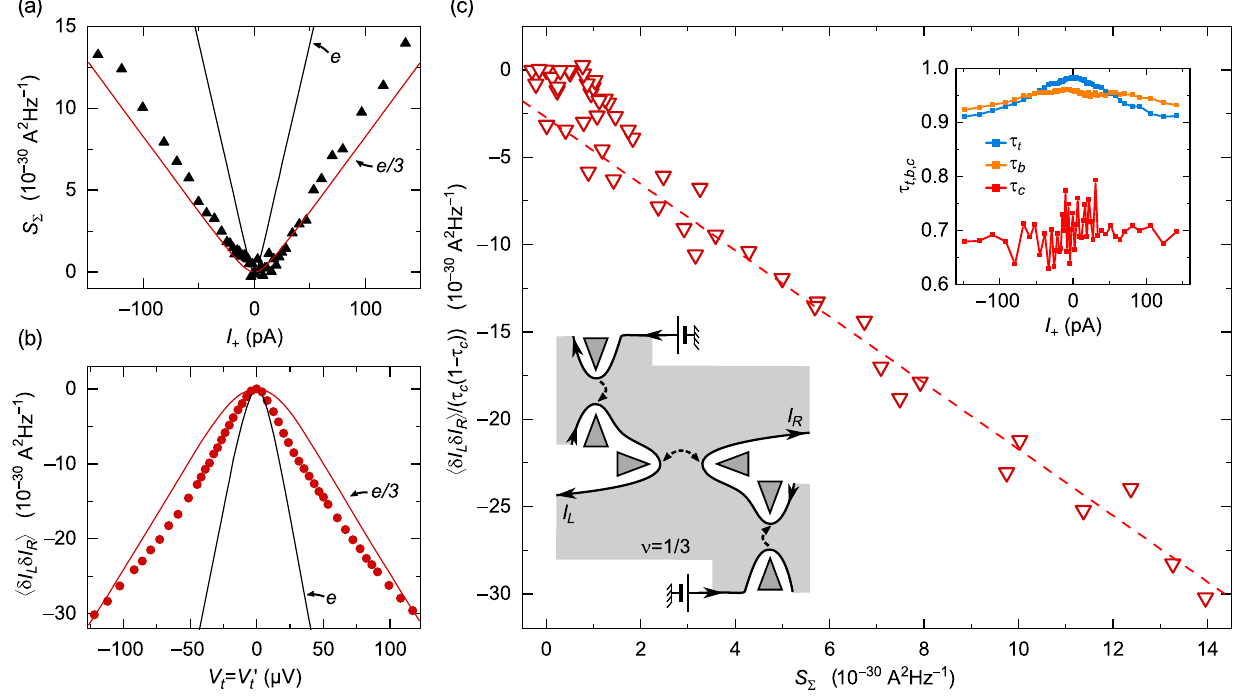
≈ 0 . 96 , t;b . A source bias c 0 ) implements a direct voltage V 0 ( V t t ¼ b ¼